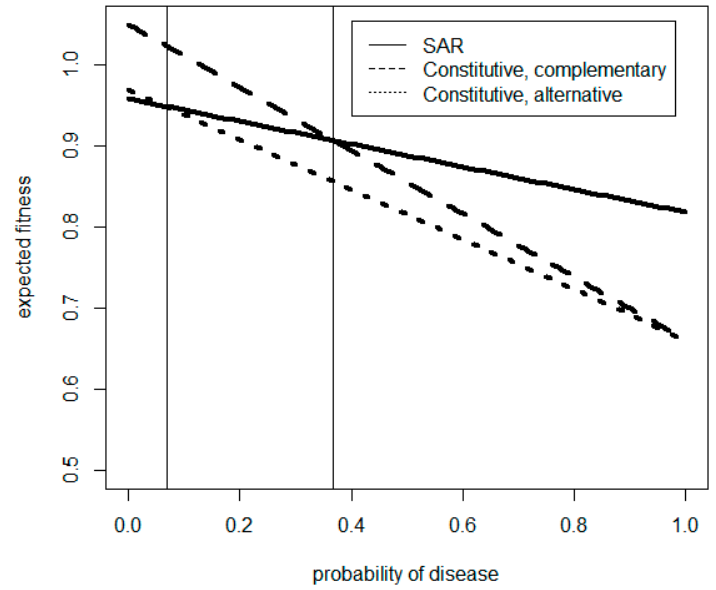
Figure 5. Solutions for Equations 1 and 2 corresponding to the values of relative fitness, E( W ), from Figure 1. showing relative fitness payouts for populations with systemic acquired resistance (SAR) under a false positive rate of 40% and a false negative rate of 20% and / or constitutive resistance, where the disease incidence, p *, at which point strategies have equal expected fitness is marked by vertical solid lines at 0.368 for the complementary constitutive population and 0.069 for the alternative constitutive population.